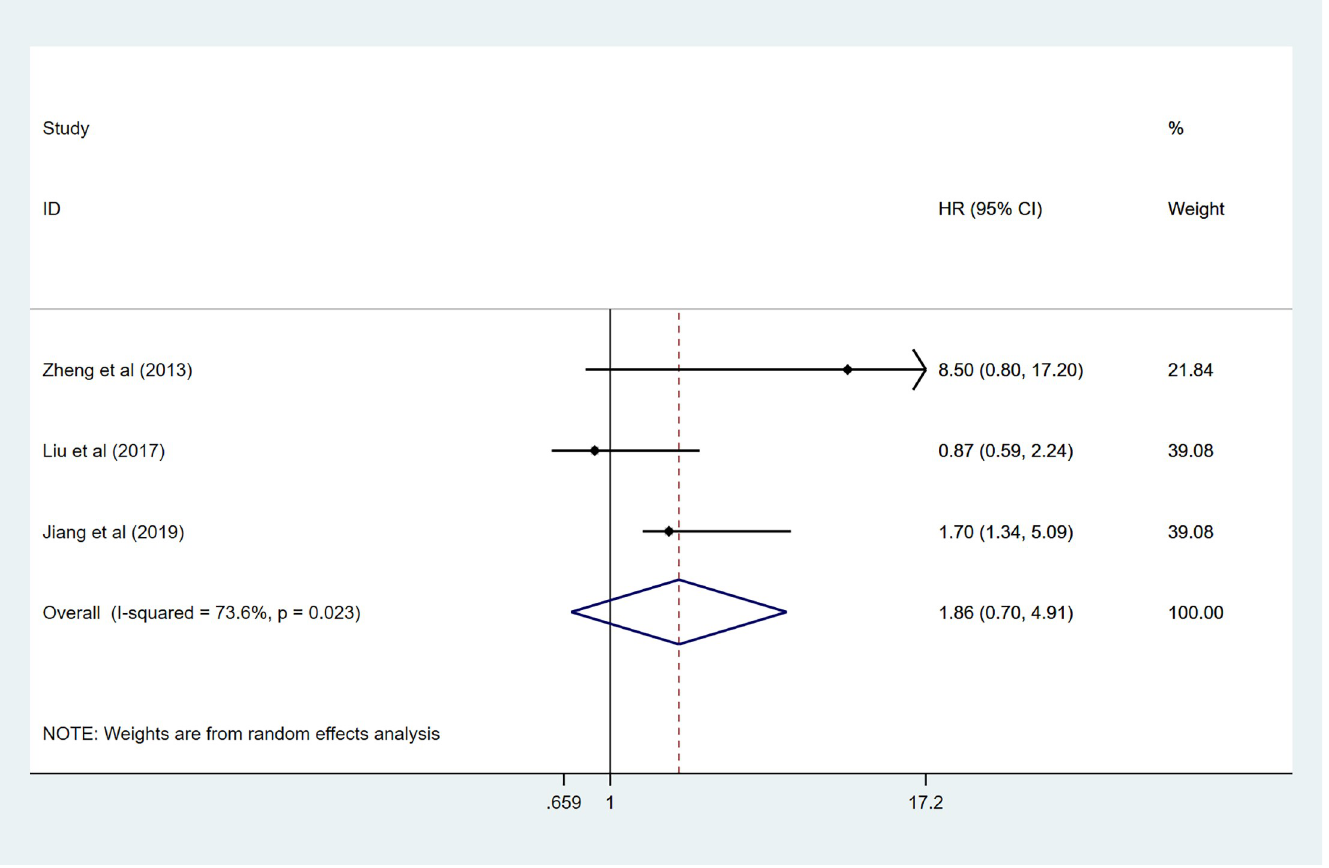
Fig 4. Forest plot for the association between GPRC5A expression and EFS.